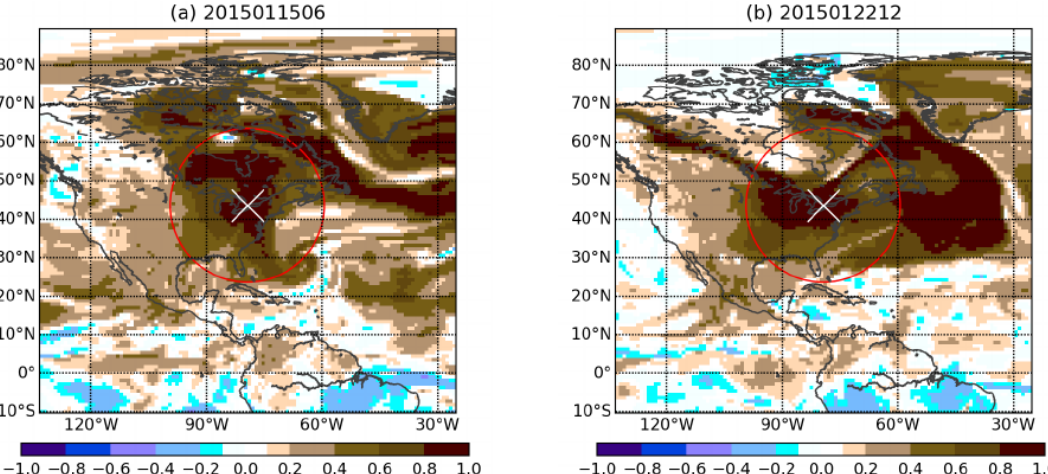
Figure 8. The spatial correlation of CO between Toronto (shown by the white cross) and other locations in the horizontal plane defined by the lowest model level. The red circle – representing a 2000km radius – shows the horizontal localization. The correlation is estimated using the 64 forecast ensemble